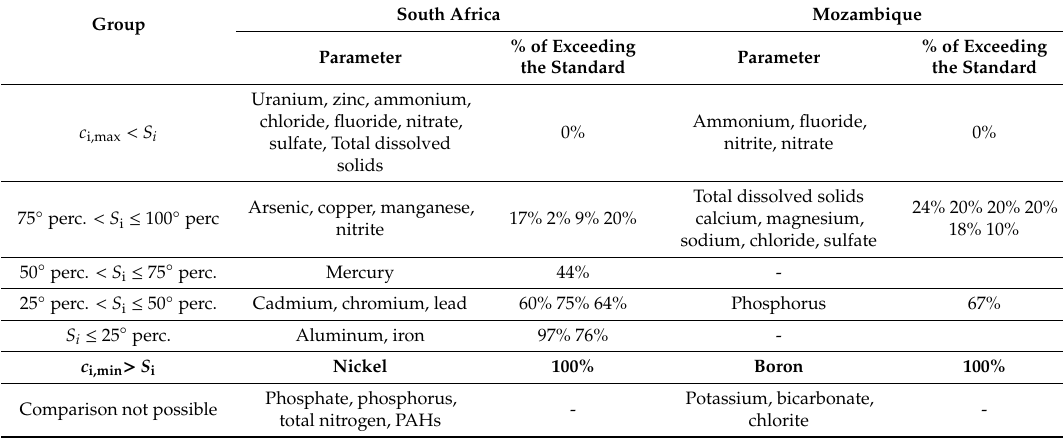
Table 4. Classification of the compounds occurring in surface water, according to